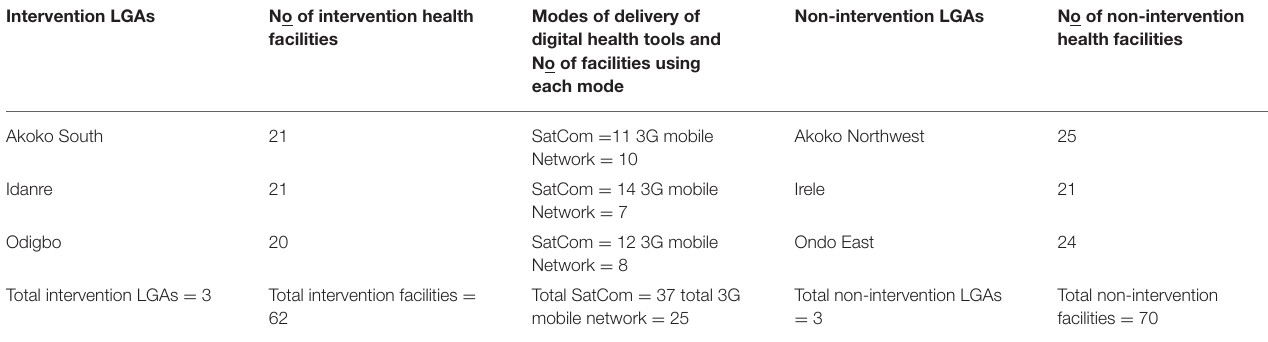
TABLE 1 | Distribution of facilities and modes of delivery of eHealth tools by local government areas (LGAs) in Ondo State.